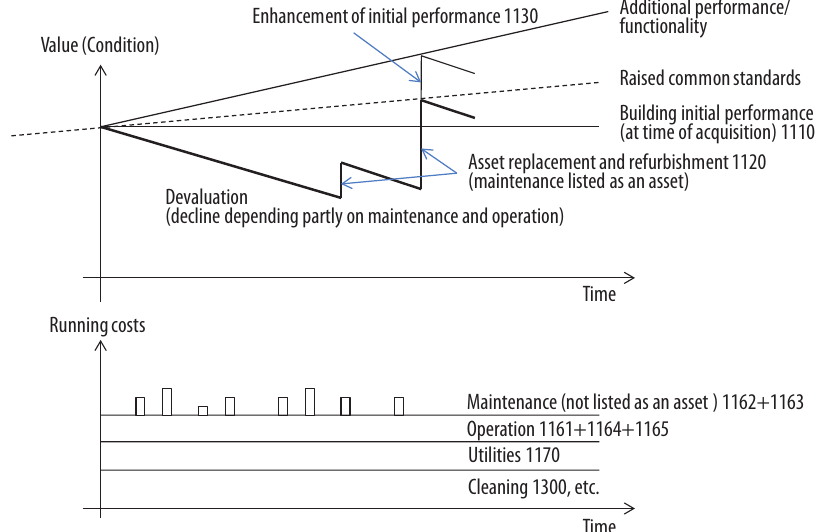
Fig. 1. Relation between maintenance and refurbishment and facility products defined in EN 15221-4 (numbers in the Figure 1 refer to facility products defined in the